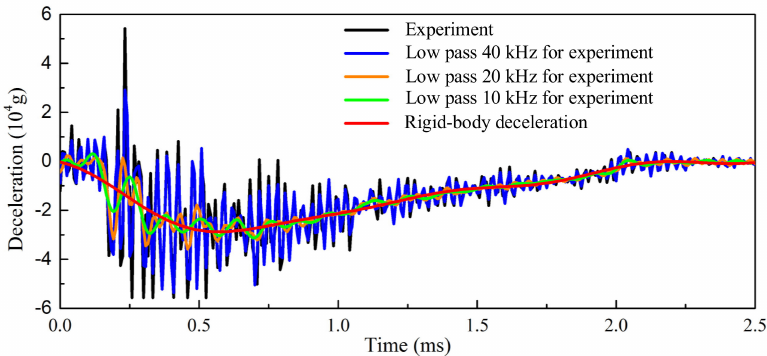
Figure 9. Deceleration–time curve from the penetration experiment (source elaborated by authors).